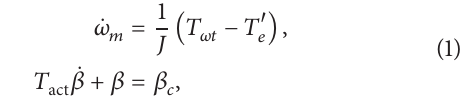
family of plant linearization about constant operating